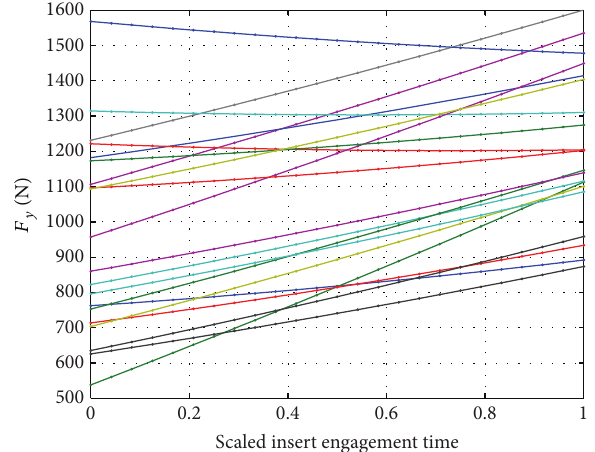
Figure 4: Functional data made out of recorded data for cutting force component in 𝑌 direction during end milling